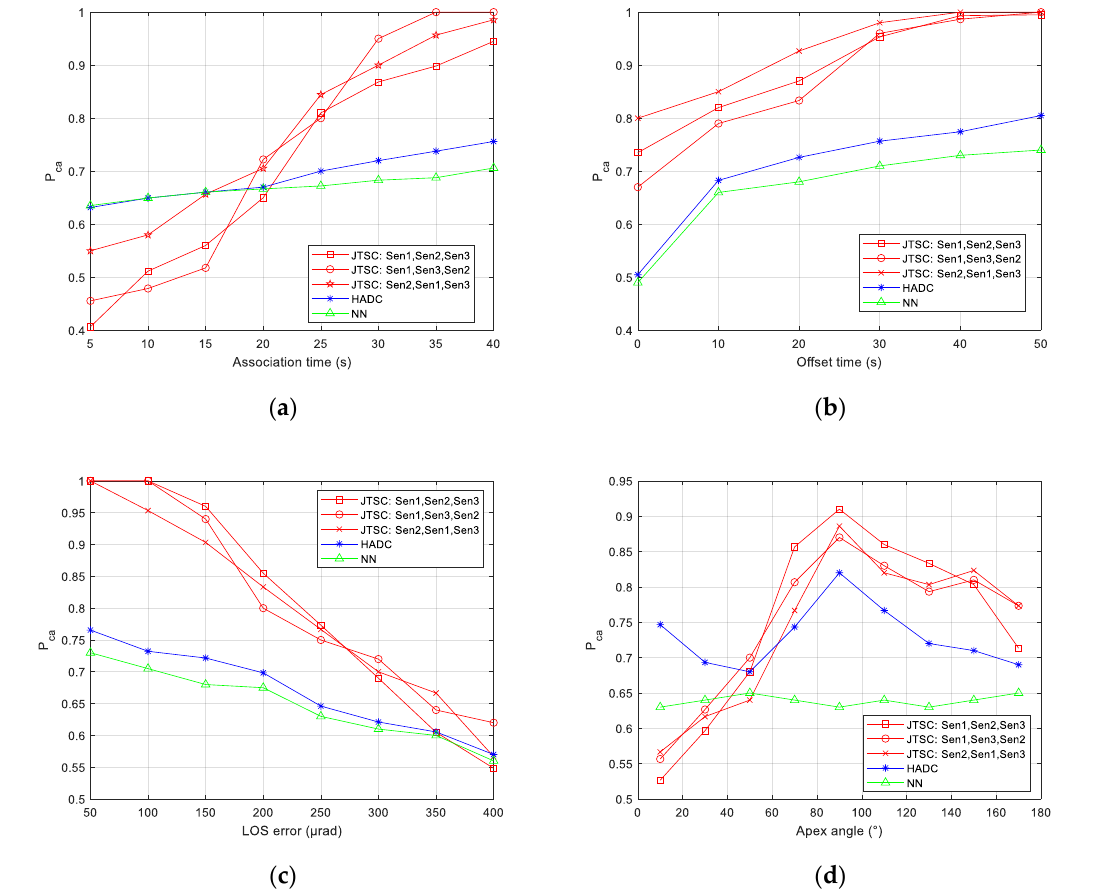
Figure 13. Probability of correct association vs. various conditions in different order. ( a ) Association time; ( b ) offset time; ( c ) LOS error; ( d ) apex angle.